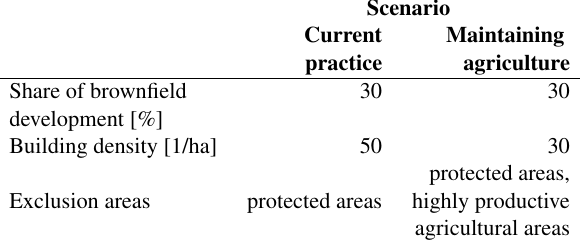
Table 2. Scenario settings. Allocation of new residential areas was limited to agricultural